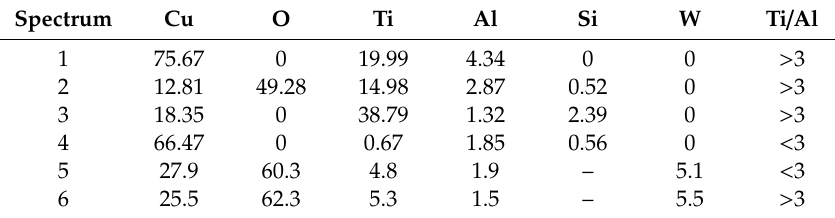
Figure 5. ( a )–( c ) Cross-sectional image of Cu-Ti 3 AlC 2 surface after being eroded 100 times by arc discharging; Energy dispersive X-ray spectroscopy (EDS) results of ( d ) in the rectangle in ( c ); ( e ) in the rectangle in ( b ) and ( f ) in the rectangle in ( c ). Table 1. The energy dispersive X-ray spectroscopy (EDS) results from Figures 5 and